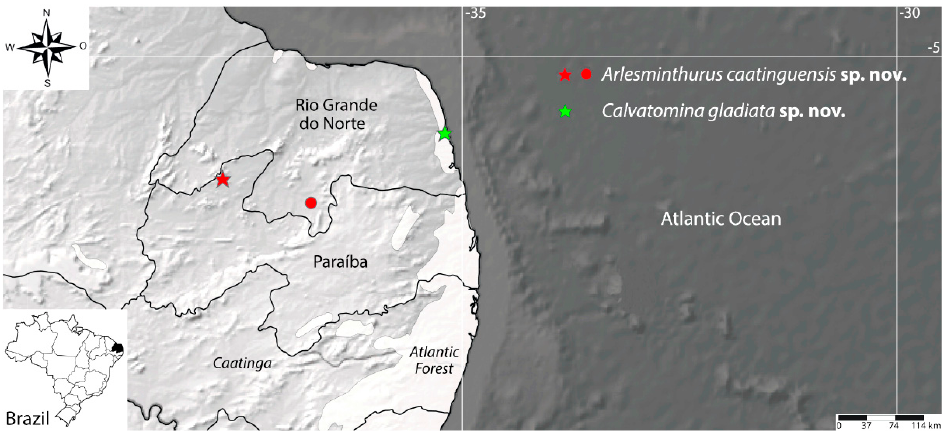
Figure 1. Map of the localities where Arlesminthurus caatinguensis sp. nov. and Calvatomina gladiata sp. nov. were found in northeastern Brazil; stars represent the type localities and the circle an additional locality for the first species.